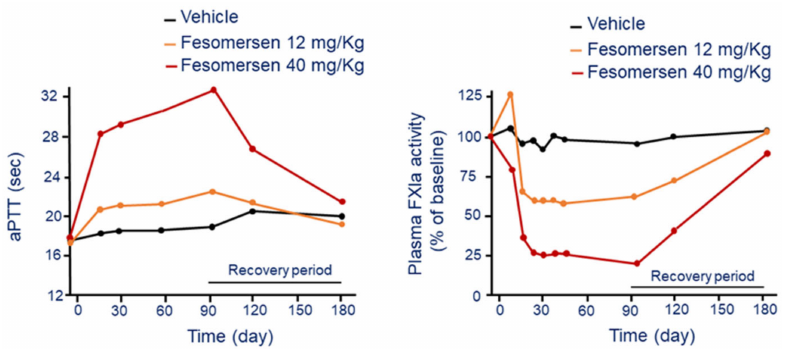
Figure 7. Dose and time-dependent effect of fesomersen on aPTT ( left panel ) and FXIa activity ( right panel ). Modified from Younis, H.S. et al. [46]. F: factor; aPTT: activated partial thromboplastin